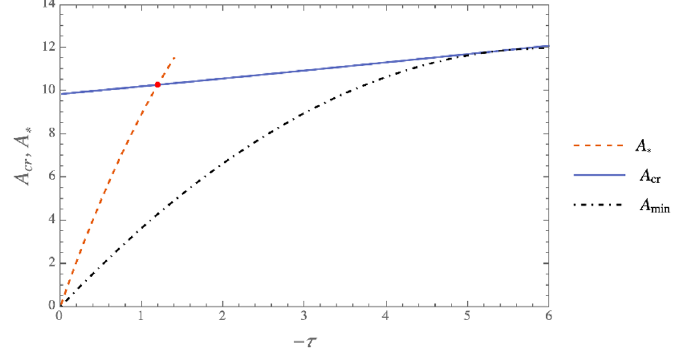
Figure 4. The location A cr of the Douglas-Kazakov and A ∗ of the 1-st order phase transitions as functions of τ . The intersection point is τ ∗ ≈ − 1 . 196 . A min corresponding to the root singularity is